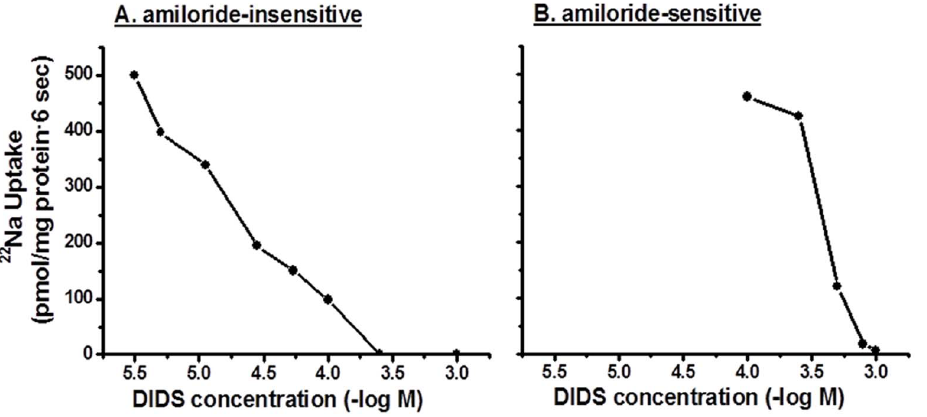
Figure 7. DIDS-inhibition kinetics of Na-HCO 3 cotransport activities in basolateral membrane vesicles from proximal colon. Increasing DIDS concentrations inhibit both amiloride-insensitive and amiloride-sensitive proton/HCO 3 gradient-driven 22 Na uptake with half maximal inhibitory concentration (Ki) of approximately 8.9 6 1.2 and 263.8 6 26.4 m M, respectively. Proton/HCO 3 gradient-driven 22 Na uptake (0.1 mM) was measured as described in the Method section with increasing extravesicular DIDS concentrations both in presence and absence of inhibitors (either 100 m M EIPA or 1 m M HOE694). Uptake obtained in presence of amiloride represented amiloride-insensitive proton/HCO 3 gradient-driven uptake. Amiloride-sensitive uptake (which also includes HOE694 sensitive Na-H exchange) was calculated by subtracting uptake obtained in presence of EIPA from that of uptake in the absence of inhibitors. HOE694-sensitive uptake was calculated by subtracting uptake obtained in presence of HOE694 from that of uptake in the absence of inhibitors. Amiloride-sensitive proton/HCO 3 gradient-driven uptake was calculated by subtracting HOE694-sensitive uptake from that of EIPA-sensitive uptake. The inhibitory constants were calculated using a nonlinear regression with the EnzFitter software (Biosoft, Cambridge,